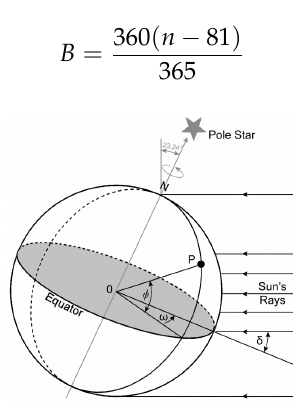
Figure 2. Hour angle ( ω ) for point P [9].